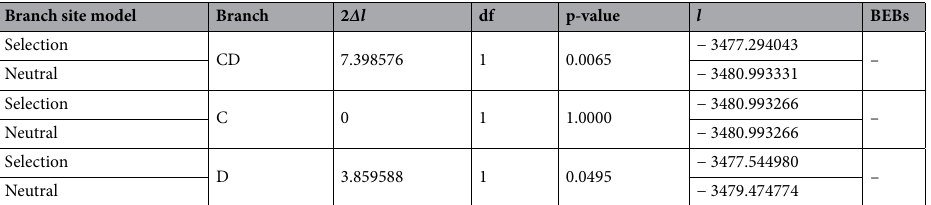
Table 2. Likelihood ratio test of branch site model performed on 296 amino acids (888 bp) of the HSP 40 kDa including the 29 of the 32 unique alleles (A11, A12 and A18 hybrid alleles are excluded from the analysis) of B. calyciflorus s.s. and B. fernandoi , B. angularis , B. diversicornis and B. rubens . Phylogeny is based on 532 bp of the ITS1. For each branch selection test, we provide log likelihood ( l ) value of the compared tests (2∆ l ), degrees of freedom (df), and the p-value. No sites were inferred to be under positive selection by BEB in this test